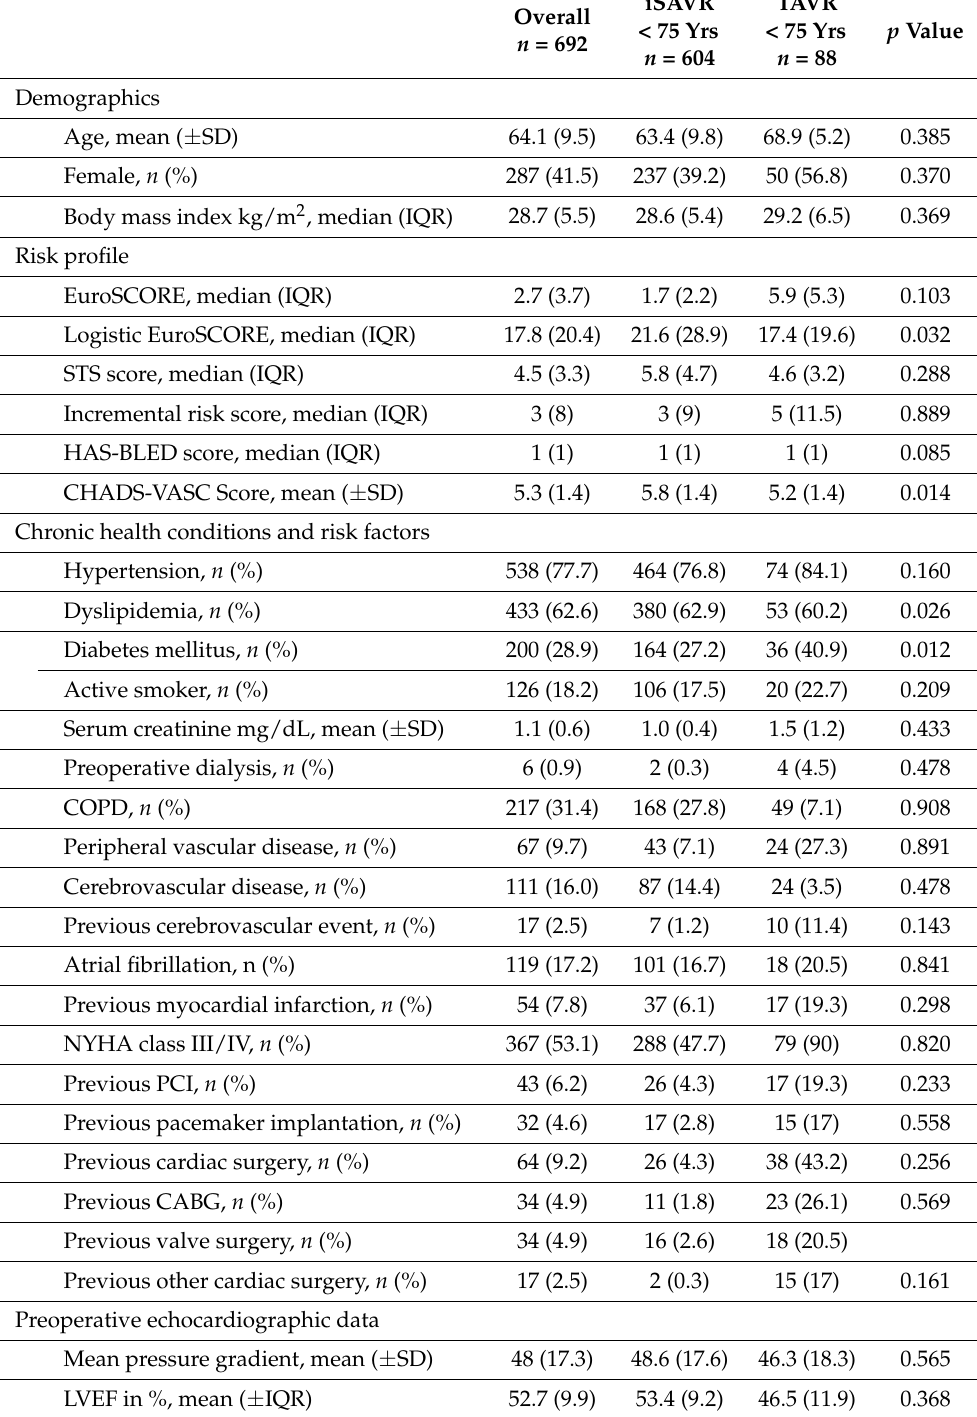
Table 2. Baseline clinical characteristics of the TAVR and iSAVR